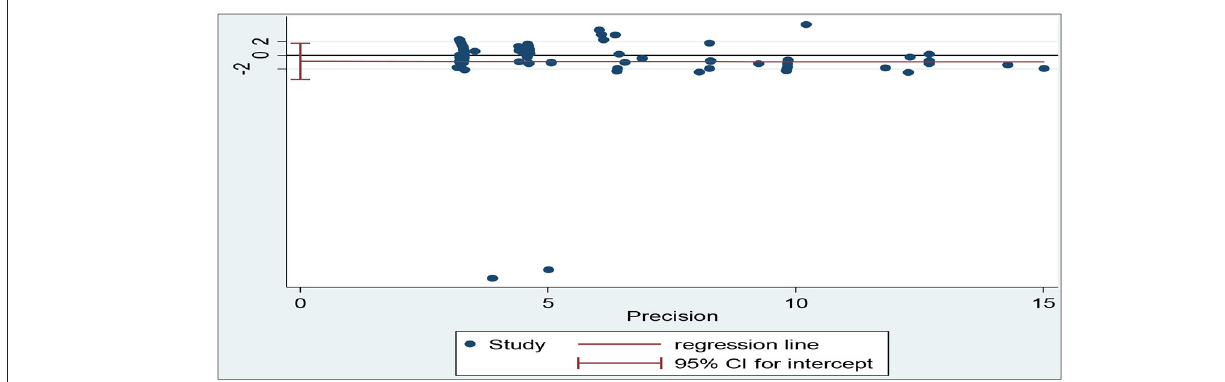
FIGURE 3 | A plot of publication bias using Egger’s test.